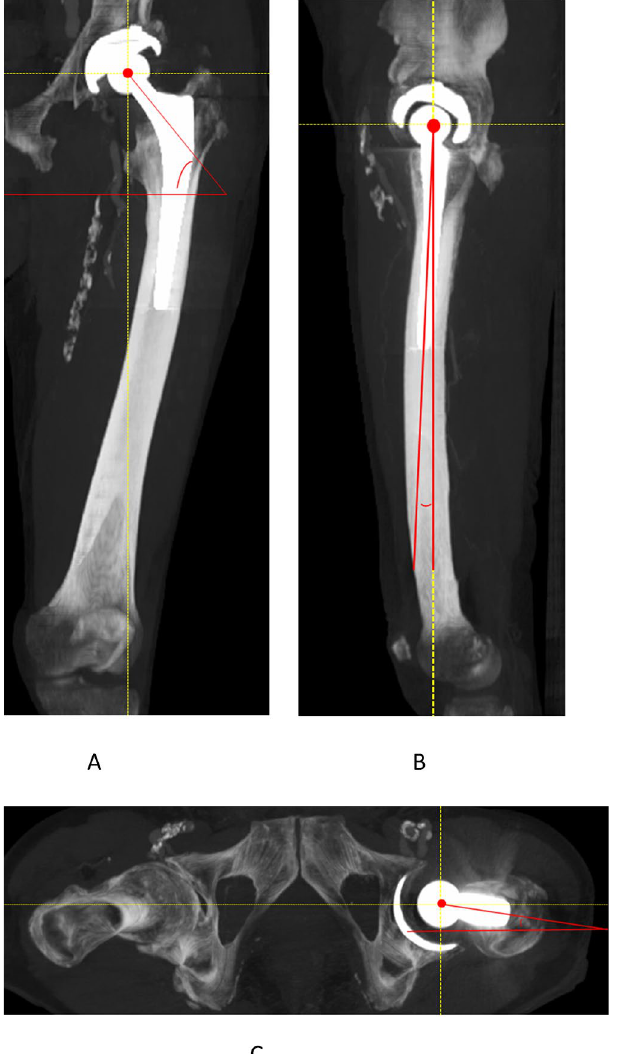
Figure 1. Measurement method of coronal inclination (CI F , defined as the angle between the line through the longitudinal axis of the neck of the femoral component and the horizontal) ( A ), sagittal inclination (SI F , defined as the angle between the line from the center of the femoral head to through the middle of the femoral neck, in relation to the vertical) ( B ) and transverse version (TV F , defined as the angle from the center of the femoral head through the femoral neck, in relation to the horizontal ( C ) of the femoral component on 3-D MIP constructed CT (horizontal/vertical displayed as dashed